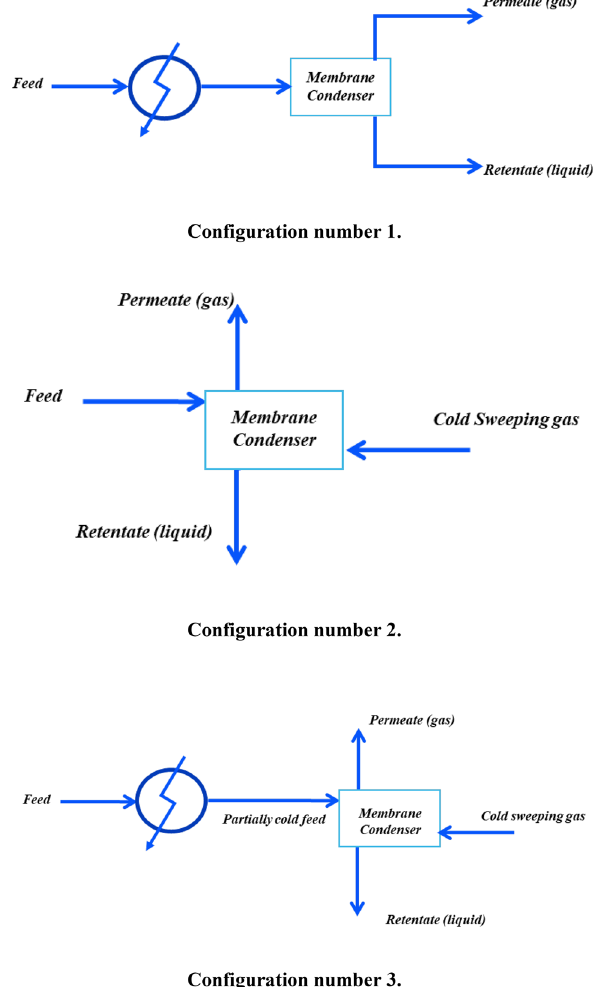
Fig. 2 Schemes of the MCo